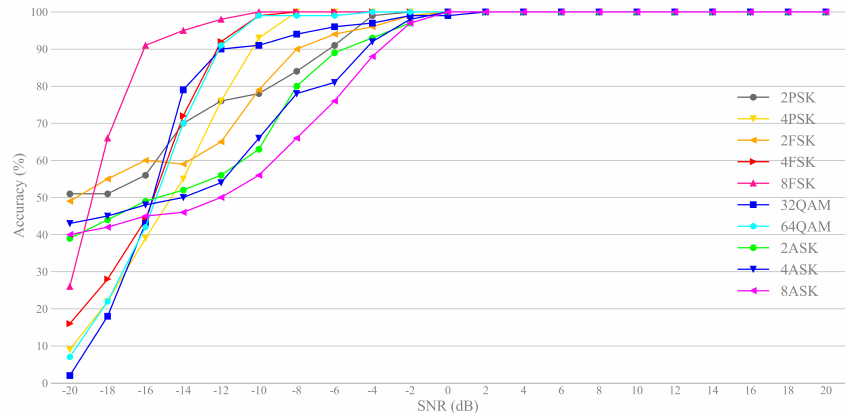
Figure 8. Classification accuracy vs. SNR for different methods.